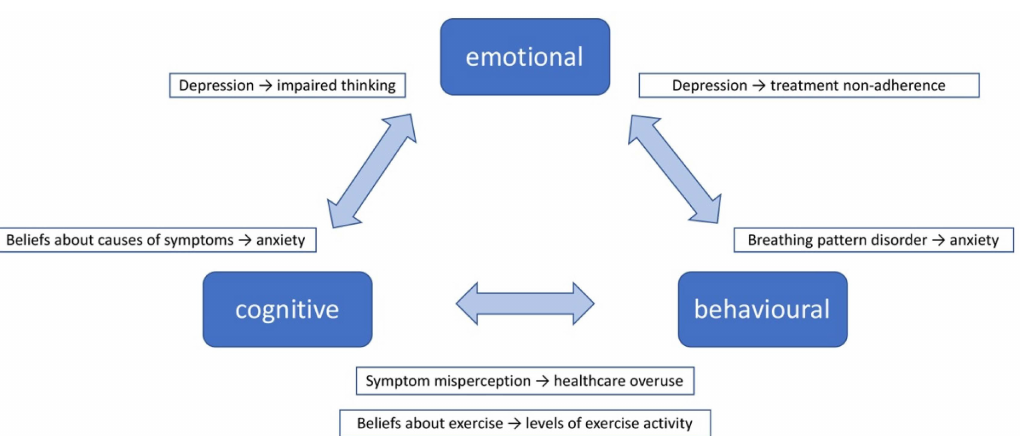
Figure 3. The interaction of emotional, cognitive and behavioural processes with examples in the context of Difficult Breathing Syndrome. Based on Yii and Koch’s framework